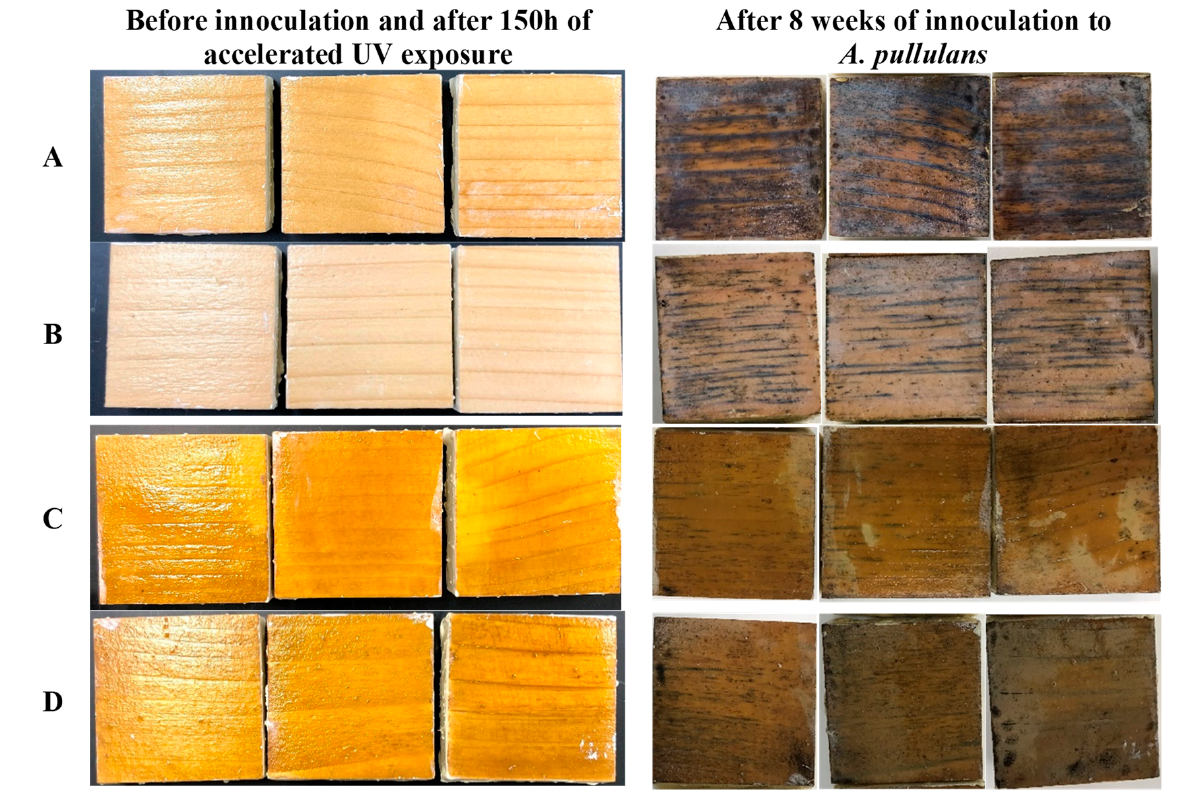
Figure 5. Photographs of samples coated with four different formulations defined in Table 1 after 150 h of accelerated UV exposure, and before and after eight weeks of incubation with A. pullulans.